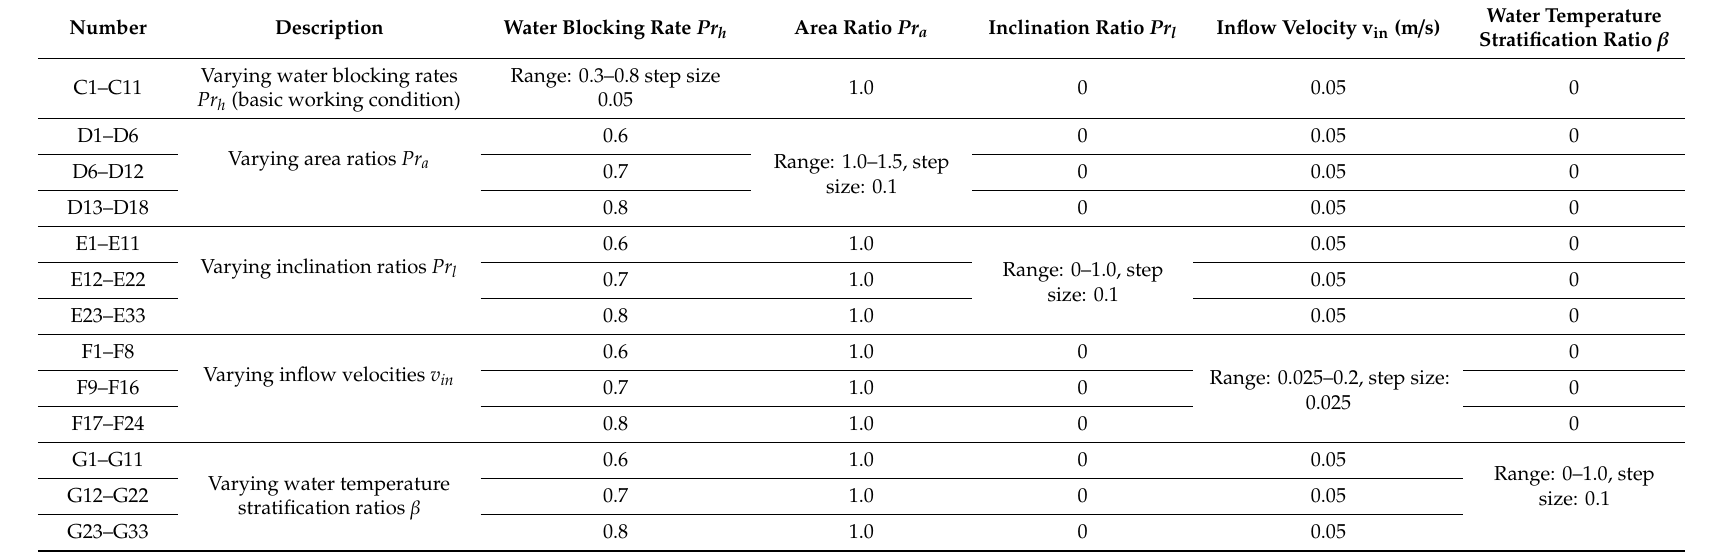
Table 3. Numerical simulation model